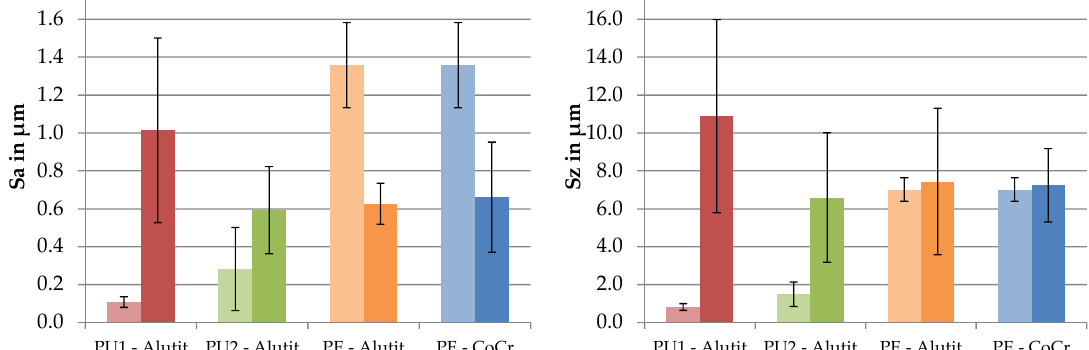
Figure 8. Surface roughness of the running surfaces of the tested samples before (left bars) and after (right bars) the wear test.